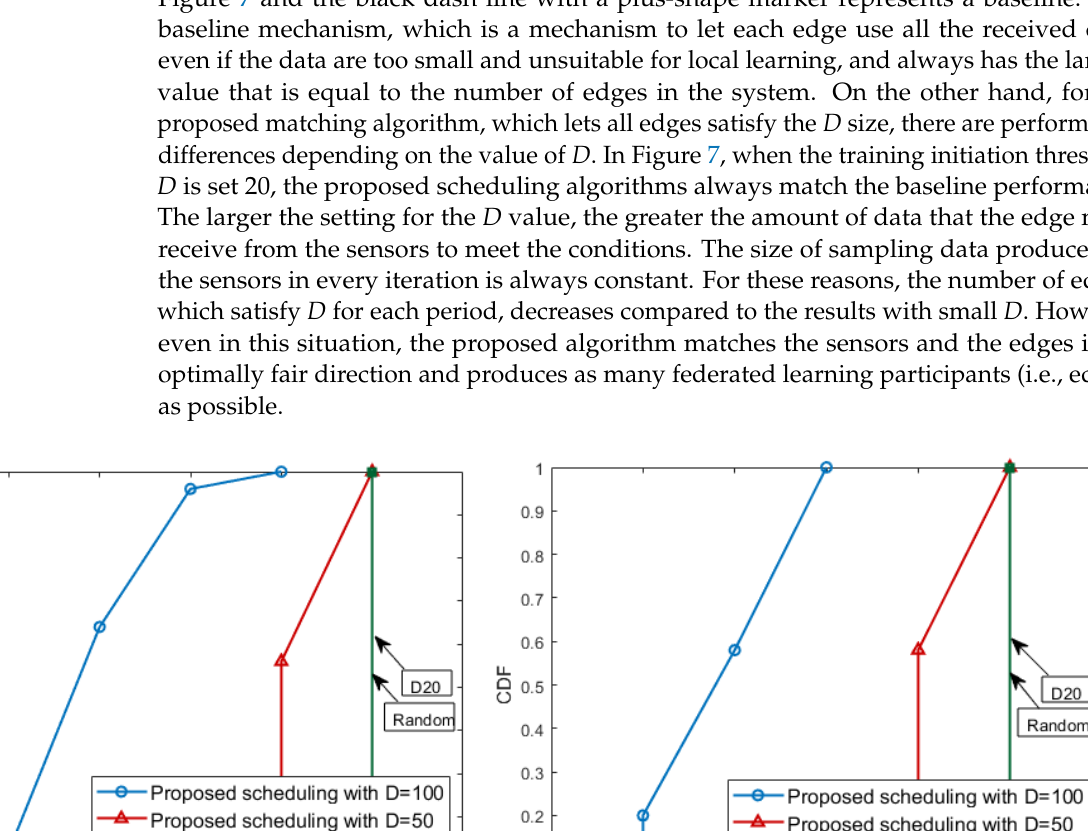
algorithm performance results. Baseline matching (i.e., randomly matched method), which ignores filling D , is used as a comparative group.